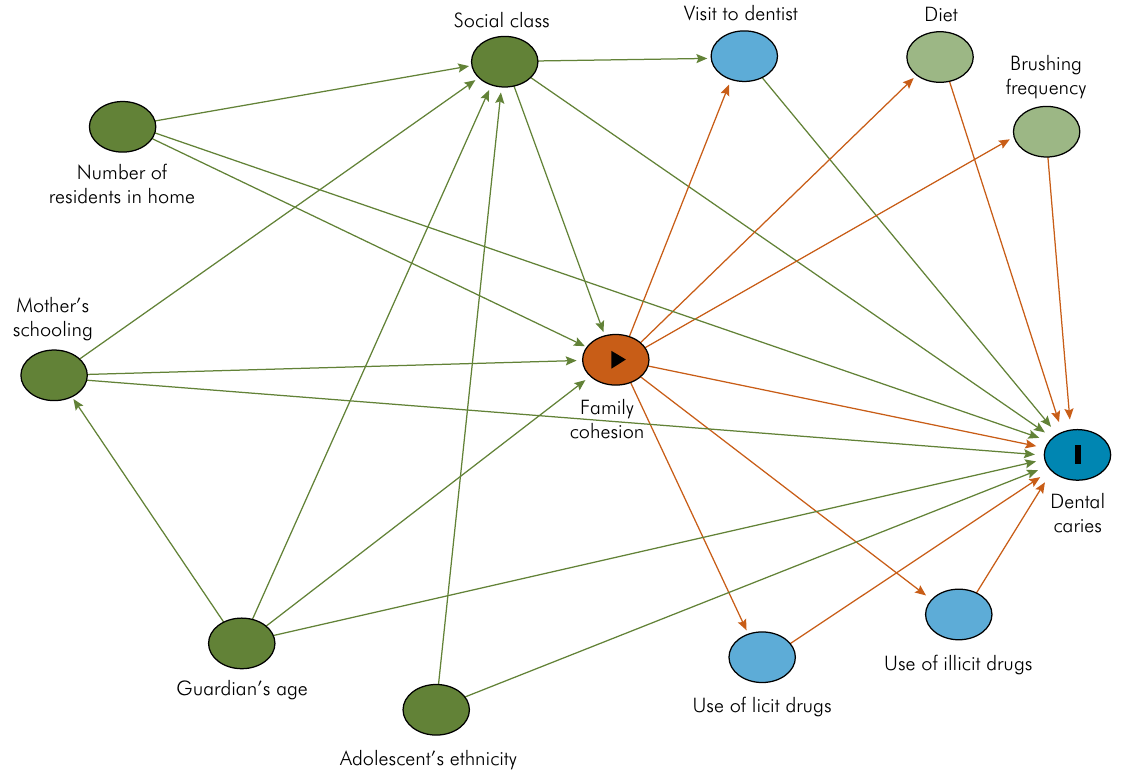
Figure. Directed acyclic graph of factors associated with number of cavitated lesions in adolescents aged 15 to 19